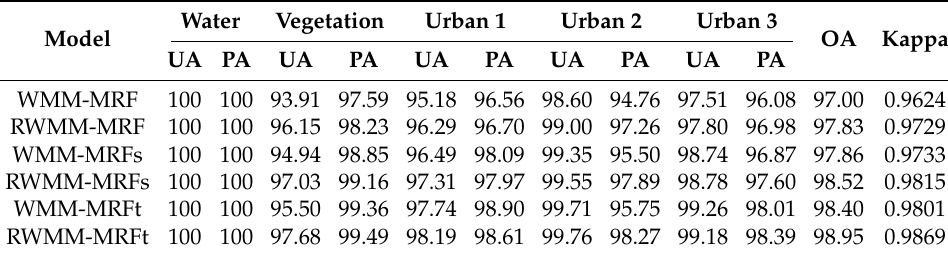
Table 4. Classification Accuracy (%) Of Six Different Algorithms on the simulated PolSAR dataset. Water Model